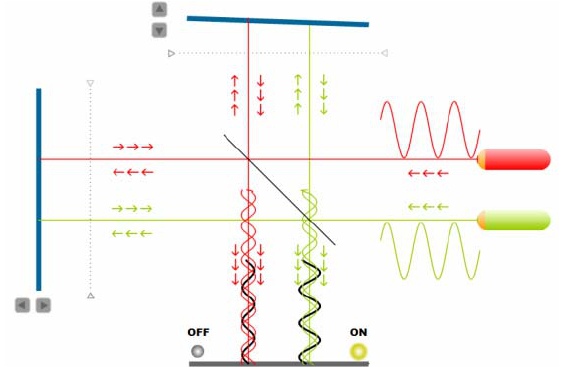
Figure 1. Simulation of interference fringe